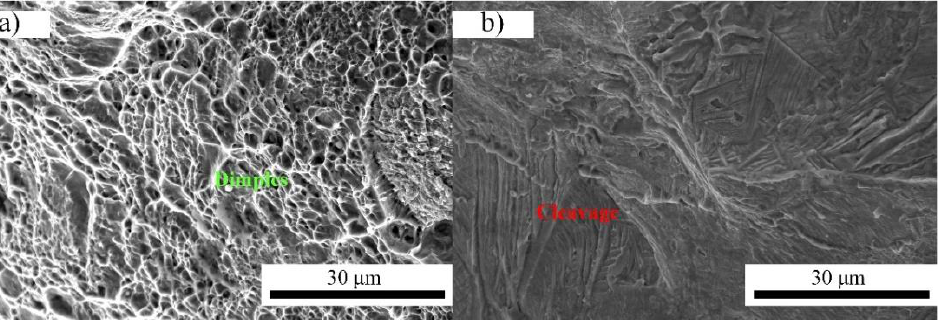
Figure 9. Slow-strain rate tensile fracture of samples A with and without hydrogen charging. ( a ) Not hydrogenated; ( b ) hydrogenated.